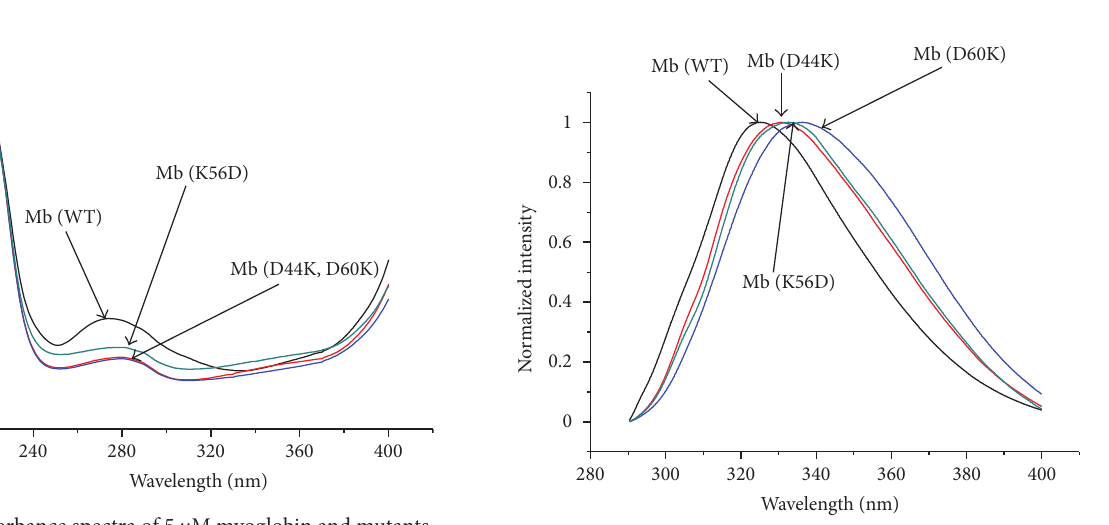
M myoglobin and 𝜇𝜇